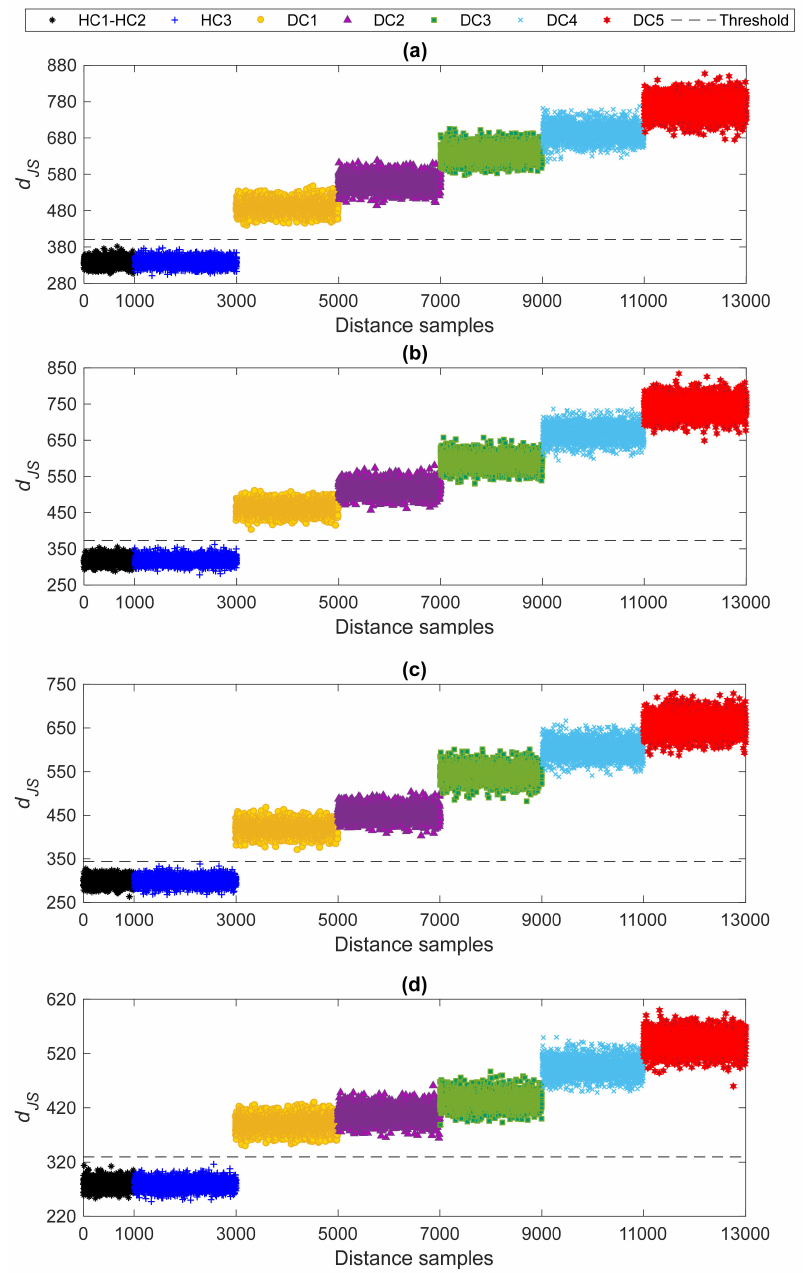
Figure 8. Damage detection by the proposed multi-level machine learning method and AR spectrum: ( a ) Case 1, ( b ) Case 2, ( c ) Case 3, ( d ) Case